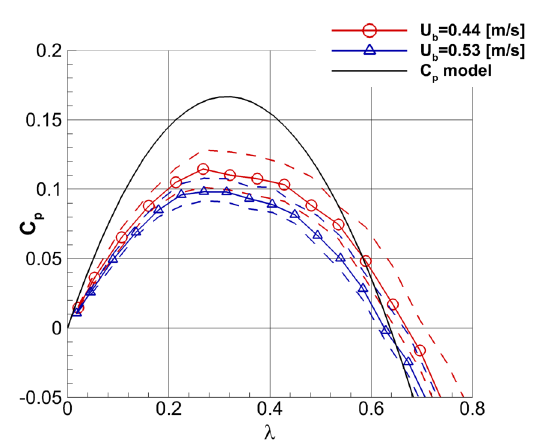
Figure 6. Power coefficient ( C p ) curves at two incoming velocities superimposed with result of power coefficient estimation model, where dashed lines represent the minimum and maximum power